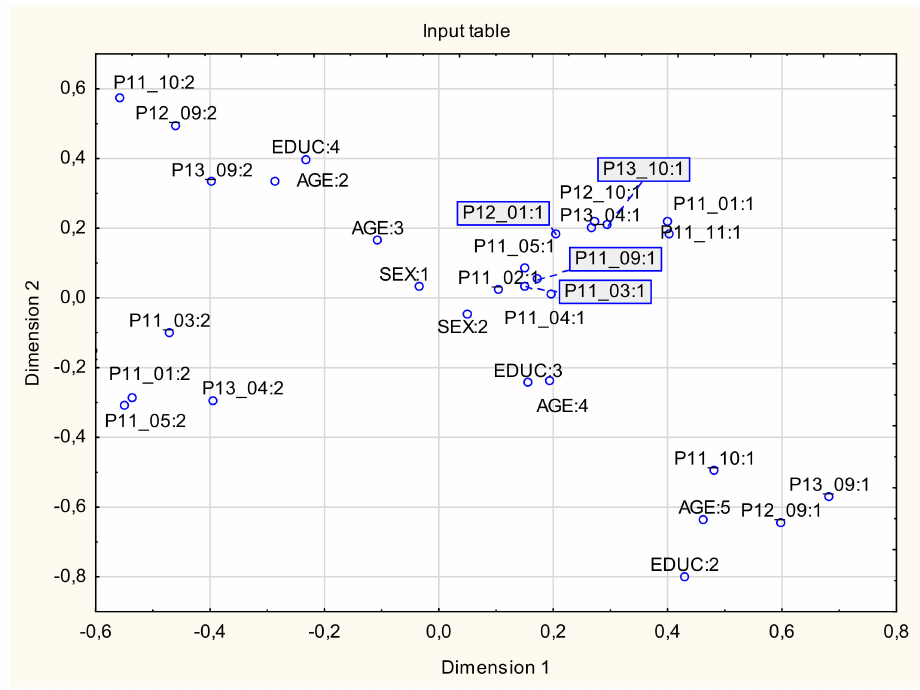
Figure 4. Two-dimensional map of perception for the variables gender, age, education and subjective evaluation of the components of